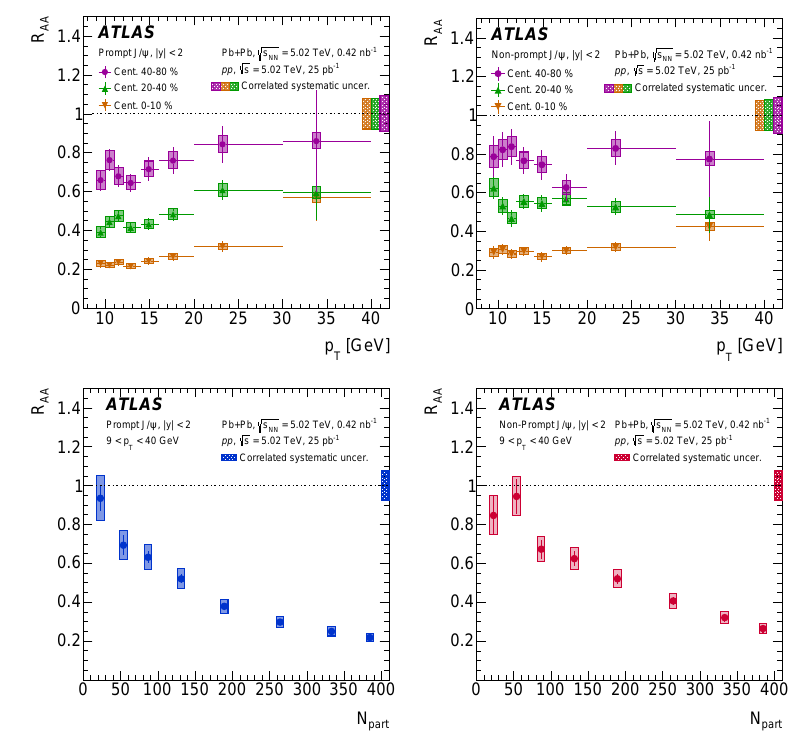
Figure 3. The nuclear modification factor as a function (top) of p T in di ff erent centrality bins and (bottom) of the number of nucleons participating in a collision, N part , for the (left) prompt and (right) non-prompt J /ψ . Figures are taken from Ref. [4].